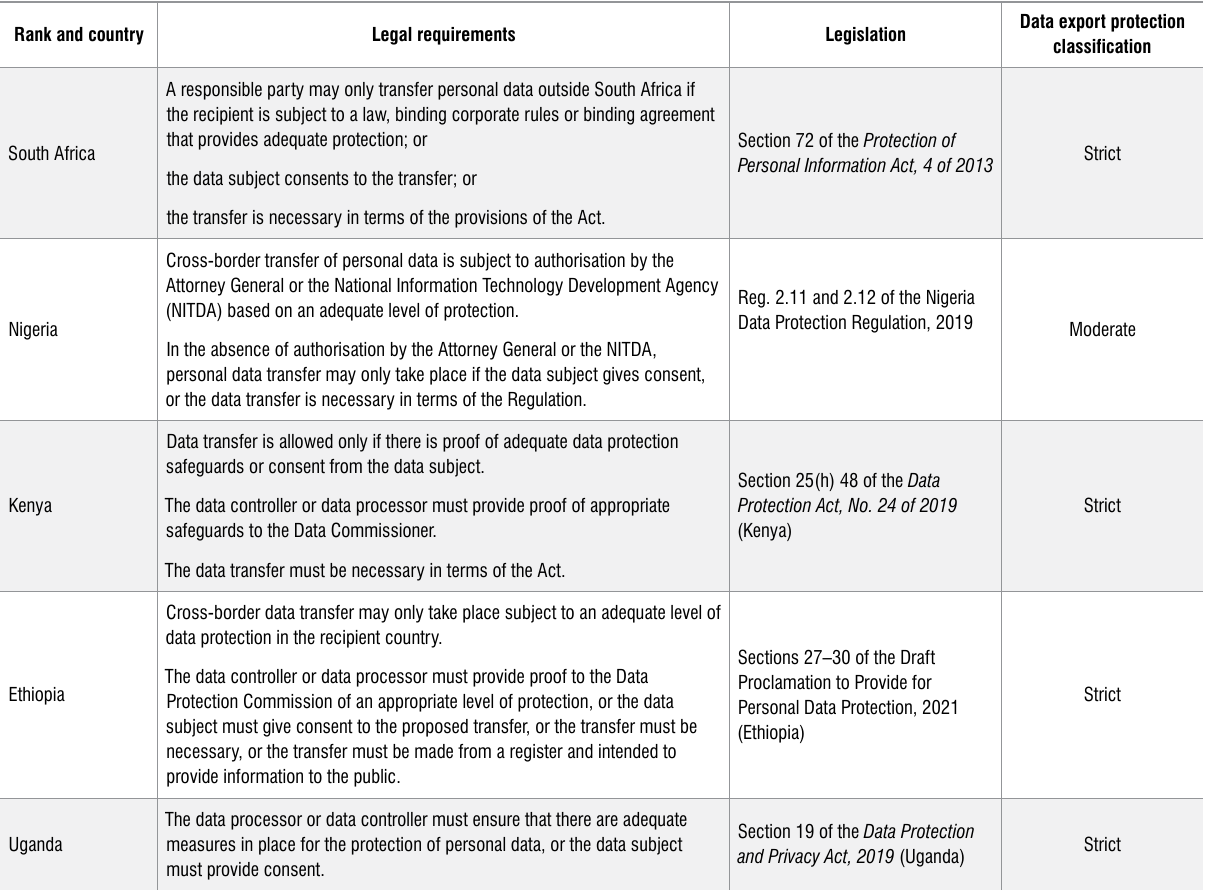
Data protection laws, regarding cross-border transfer of personal data, of sub-Saharan African countries ranked by research output in “Public Health, Environment, and Occupational Health”